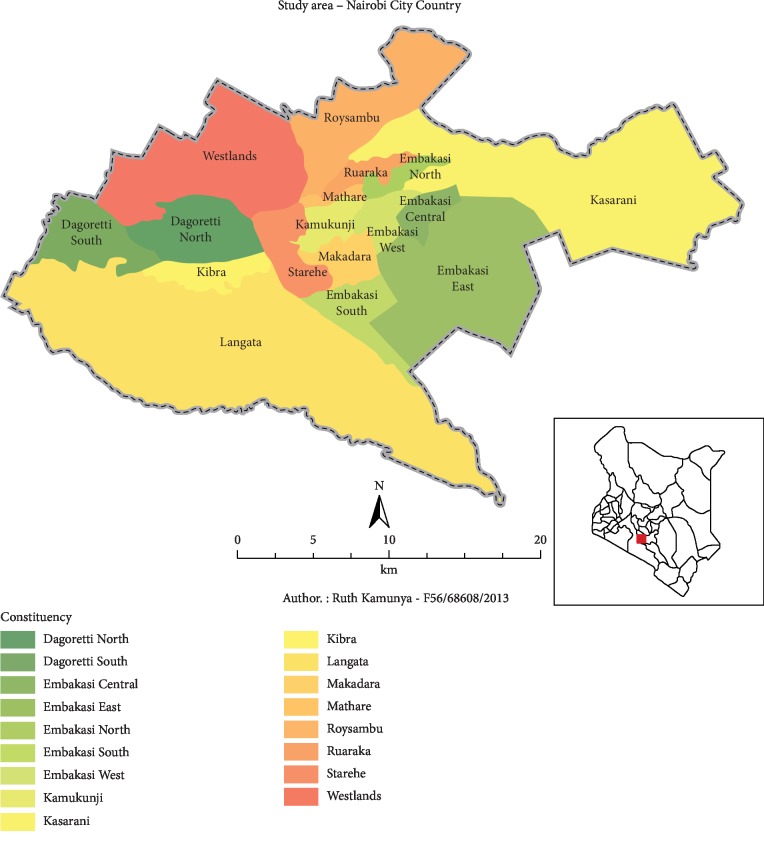
Map of Nairobi County [19].